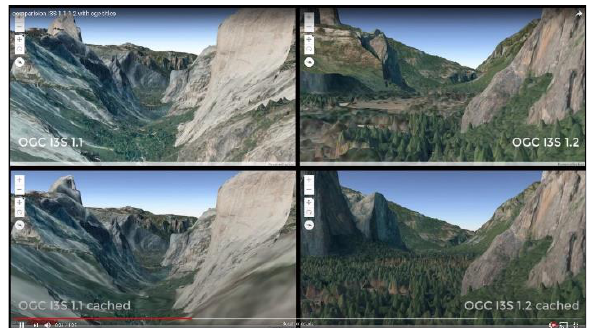
Figure 2 . Snapshot showing loading performance of I3S OGC 1.1 community standard compared to OGC I3S 1.2. As shown in the video, https://youtu.be/chRpgjIDkzc, the scenes on the left column correspond to I3S OGC 1.1 and take approximately 75 and 60 secs to completely render, whereas the scenes on the right column corresponding to OGC I3S 1.2 and take 30 and 25 seconds, with and without any client-side browser caching, respectively in both cases. Data provided by